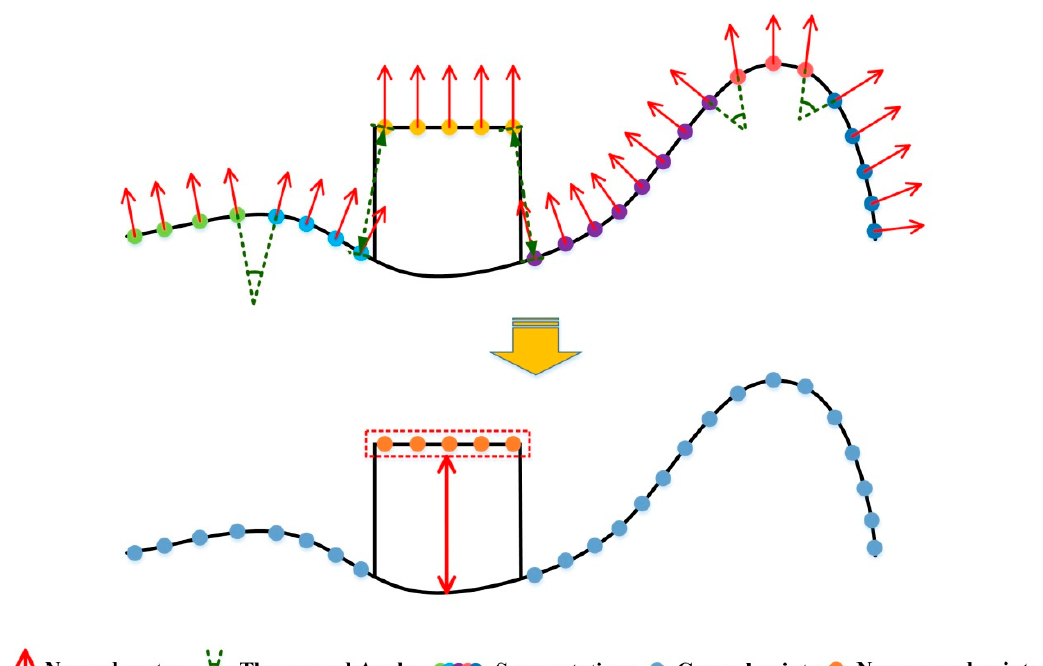
Figure 4. Schematic diagram of region growing segmentation-based filtering.